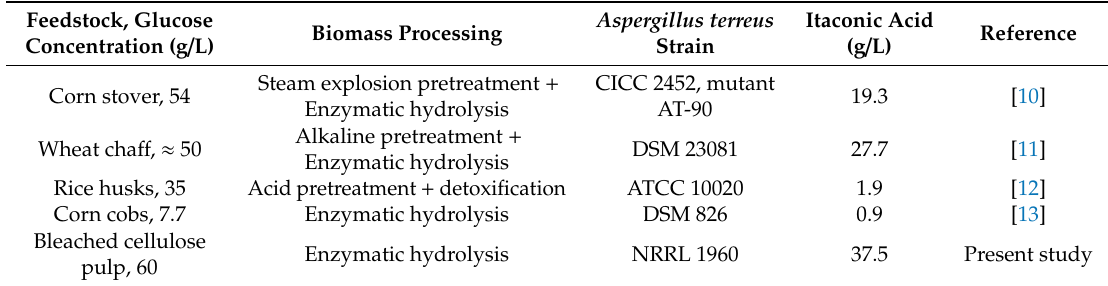
Table 8. Production of itaconic acid by A. terreus from di ff erent lignocellulosic feedstocks. All the values correspond to experiments in